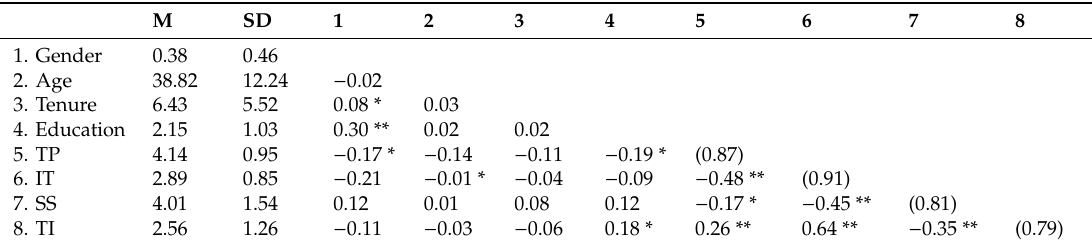
Table 1. Means, Standard Deviations, Correlations and Cronbach’s Alpha.